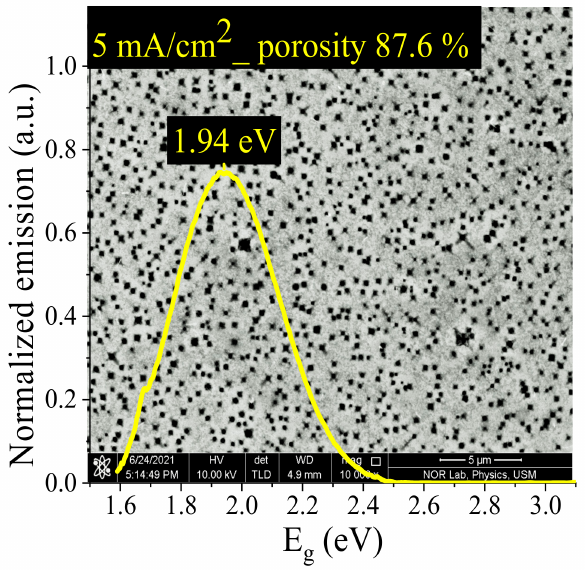
Figure 2. FESEM morphology combined with PL of the PSi etched at 5 mA/cm 2 .